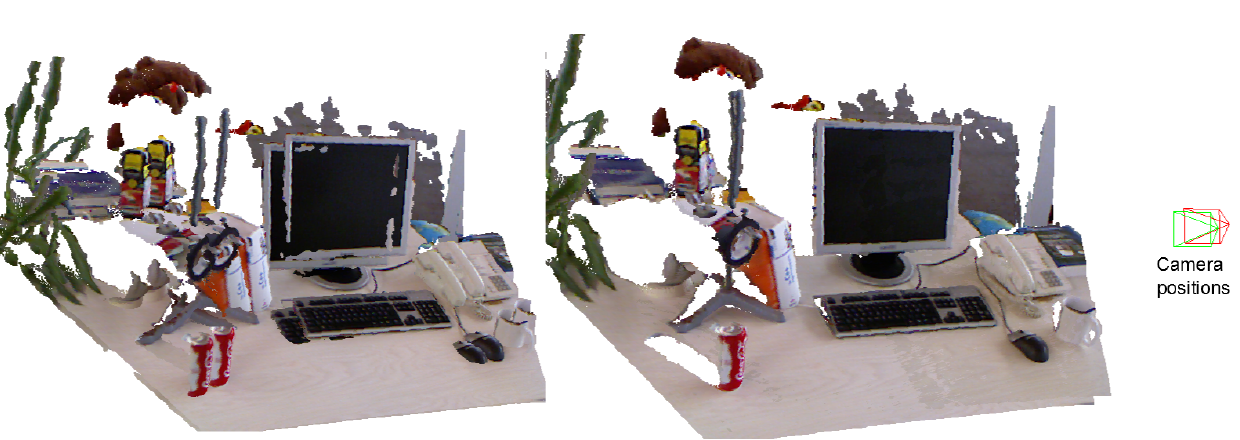
Figure 1. ( Left ) Two non-aligned point clouds. ( Right ) Both point clouds aligned and the estimated and reference positions of the